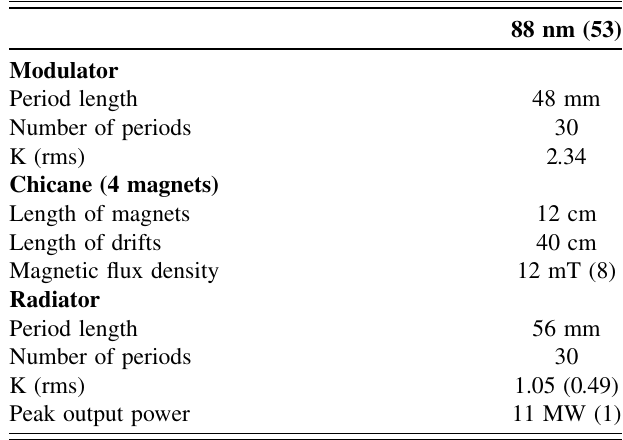
TABLE III. Parameters of the undulator section of the MAX- lab-BESSY FEL when tuning the radiator to the 3rd harmonic (88 nm) of the seed laser. In parentheses, the properties for the 5th harmonic (53 nm) are also